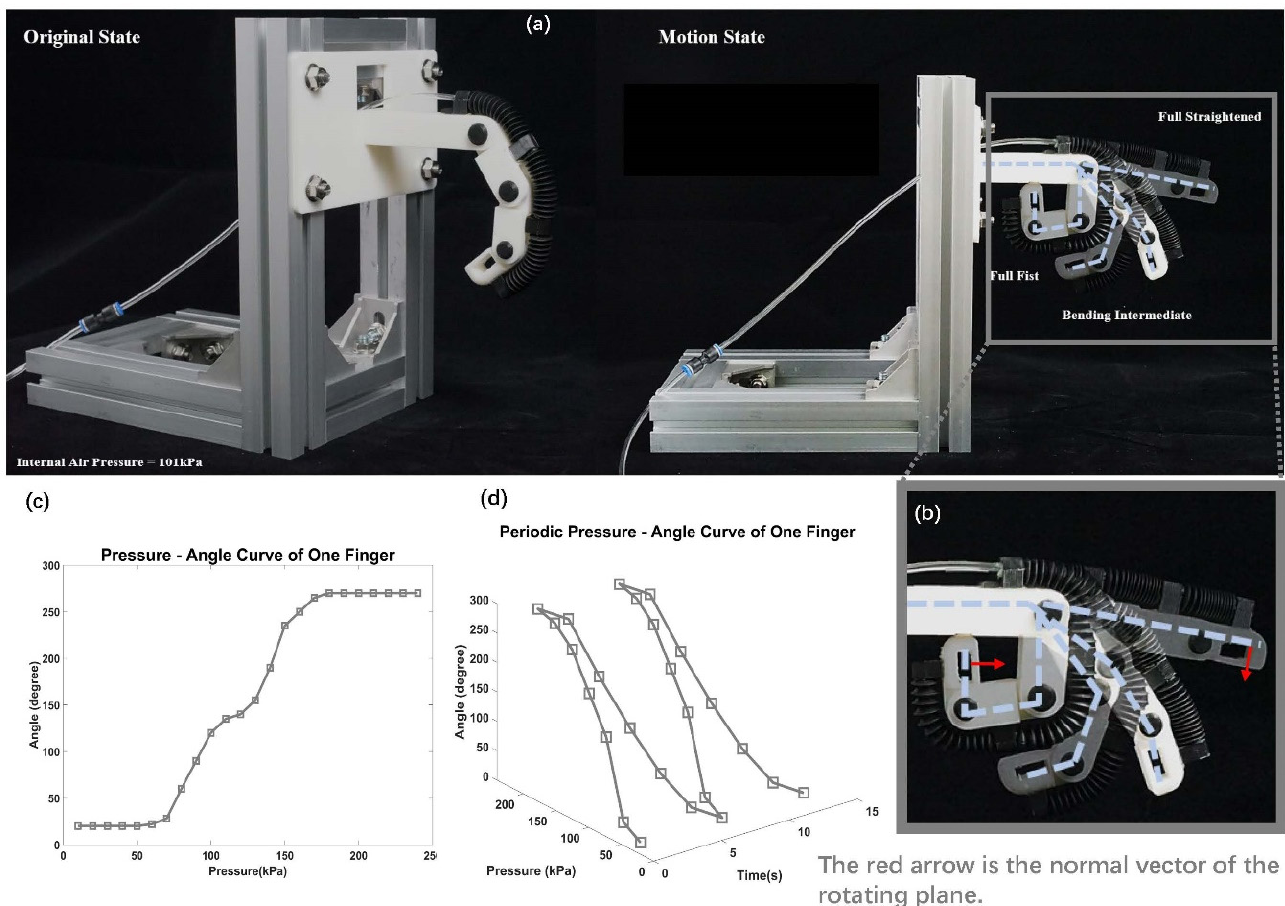
Figure 8. Motion of the bionic finger driven by the three-linked GBBAs. ( a ) Original state and motion process of the bionic finger from full straightened to full fist; ( b ) the IMU sensor collects the normal vector of the fingertip angle during movement; ( c ) fitting curve of fingertip angle of bionic finger with internal air pressure; ( d ) periodic bending angle curve with air pressure: relationship between bending angle and internal air pressure in two cycles.